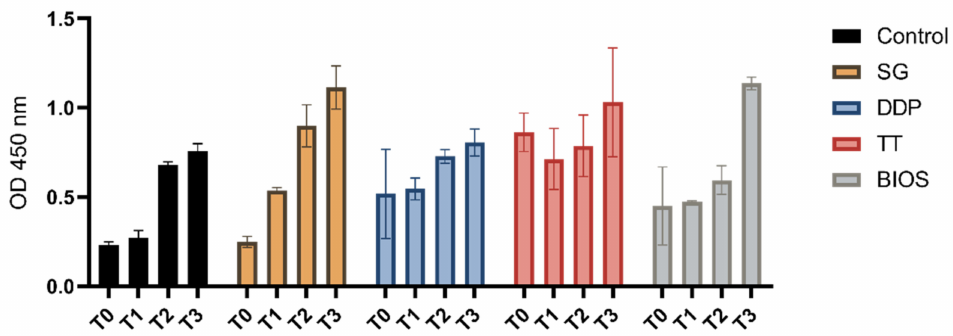
Figure 1. Separated graph bar showing the grouped data of mean and SD of the optical density values ( Y -axis) of the cell not exposed to materials (Control), the cell exposed to tested materials (SG, DDP, and TT), and the cell exposed to the positive control material (BIOS) at the different timings (T0—moment of seeding; T1—24 h after seeding; T2—72 h after seeding; and T3—7 days after seeding).